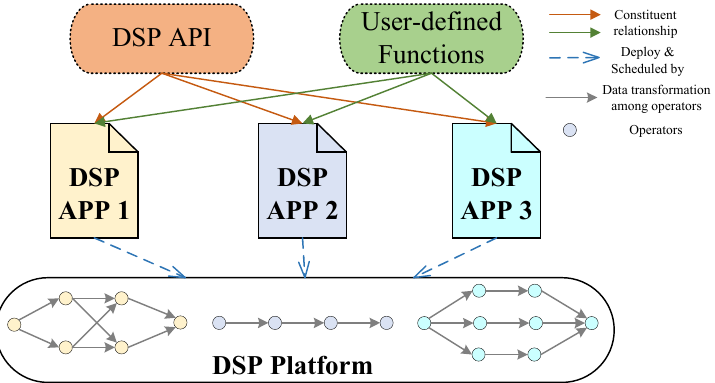
Figure 1. Compositions of DSP applications and their relation with DSP